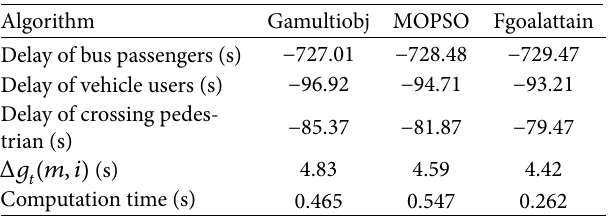
Table 6: Results of delay model in situation 2 during the peak period. Algorithm